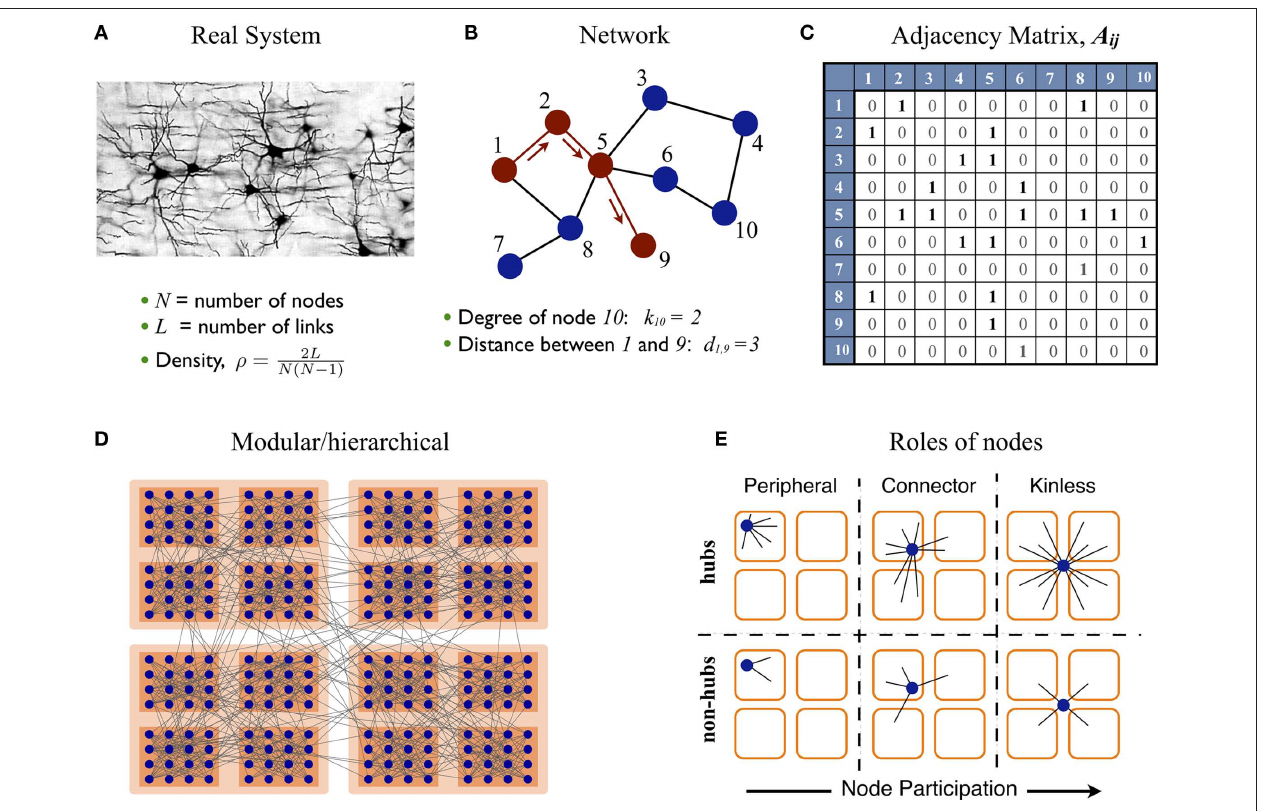
larger modules and hierarchies. (e) Given a network with modular organization its nodes can take different positions. These can be characterized by two parameters: (i) the global importance of the node or hubness, and (ii) the dispersion of the links of the node throughout the modules, referred as node’s